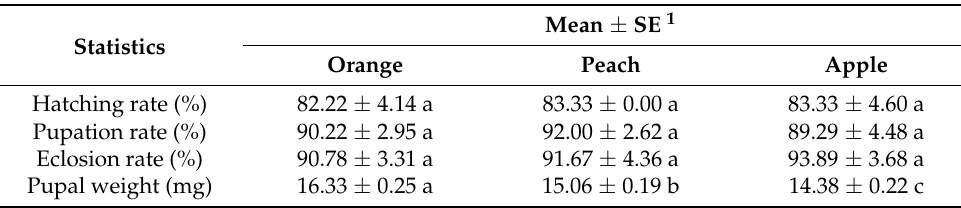
Table 1. The hatching rate, pupation rate, eclosion rate, and pupal weight of Bactrocera dorsalis on three host